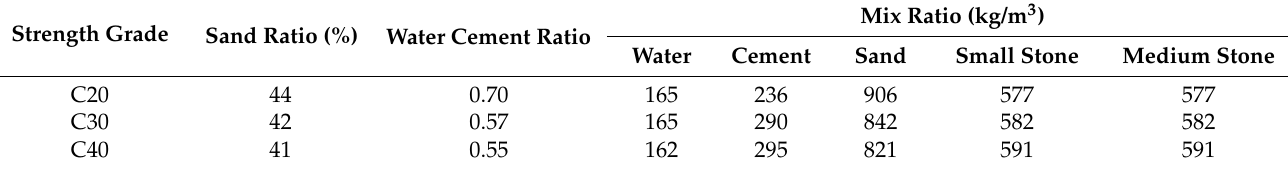
Table 1. Concrete mix ratio and main